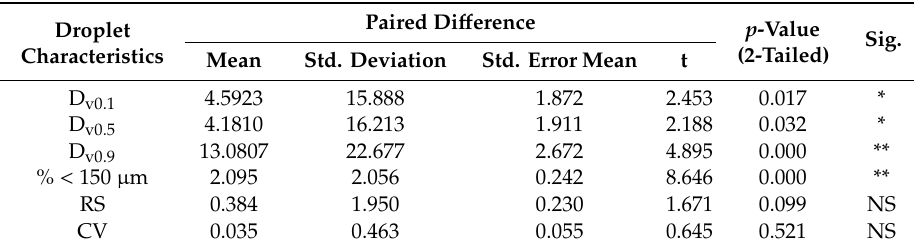
Table 3. The t-test values of droplet characteristic values before and after analysis of covariance (ANCOVA). P-value: The probability of obtaining the observed results; NS: Not significant, *: Significant, and **: Highly significant.